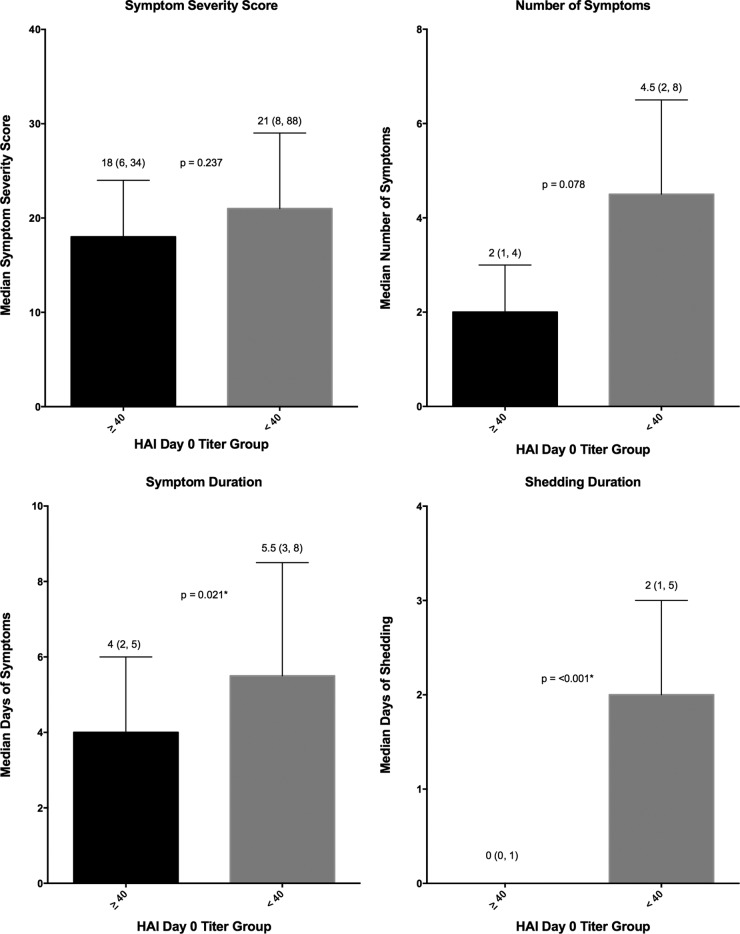
Disease severity measures in high- and low-HAI-titer groups. Symptom severity score (FLU-Pro participant self-assessment), number of symptoms, symptom duration, and shedding duration were evaluated for the participants in the groups with an HAI titer of ≥1:40 or <1:40. The median values (indicated by the bars) are shown as the first value above the bar. The interquartile ranges (indicated by the error bars) are shown in parentheses above the bars. The P values generated by the Wilcoxon rank sum test (two sided at 0.05 level) are indicated between the bars for the two HAI titer groups; P values that are statistically significant are indicated by an asterisk.